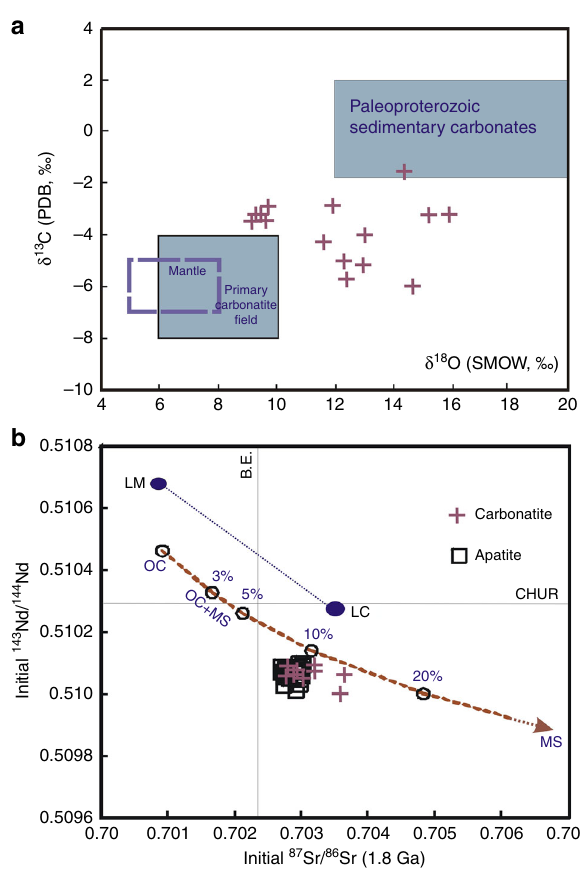
Fig. 4 Isotopic compositions of the carbonatites. a The carbonatite samples from Fengzhen and Huai ’ an show higher oxygen and carbon isotopes compared to normal mantle-derived rocks (box with dashed line) and typical primary carbonatites (gray box with black line) worldwide. The values of the Paleoproterozoic sedimentary carbonates 30 are also shown to illustrate that heavy-C enrichment in the carbonatites is consistent with the involvement of recycled oceanic carbonates. b The initial 143 Nd/ 144 Nd and 87 Rb/ 86 Sr ratios of the carbonatites and apatites are compared to the values of the Archean to Proterozoic lithospheric mantle (LM) 31 and the late Archean lower crust in central NCC (LC) 32 with 700-Ma radiogenic addition. The Sr – Nd isotopic variations for the sources of the carbonatites and apatites can be successfully modeled by mixing a 2.5-Ga oceanic crust (OC) with various amounts of 2.5-Ga marine sediments (MS) (Supplementary Table 11). With a single-stage evolution model 54 , the isotopic compositions of the two end-members are calculated as ( 87 Rb/ = 0.053 and ( 147 Sm/ 144 Nd) = 0.214, and ( 87 Rb/ 86 Sr) = 86 Sr) OC OC MS 0.186 and ( 147 Sm/ 144 Nd) MS = 0.183, respectively. The initial Sr – Nd isotopic compositions of the LC in the central NCC, and those for the bulk Earth (BE) and chondritic uniform reservoir (CHUR) are calculated for 1.8 Ga the source. The initial Sr and Nd isotopes of the Archean to Proterozoic lithospheric mantle 31 and TTG crust in the central NCC 32 are very depleted, so that a 700-Ma radiogenic addition cannot produce such an enriched Sr – Nd isotopic signature for the